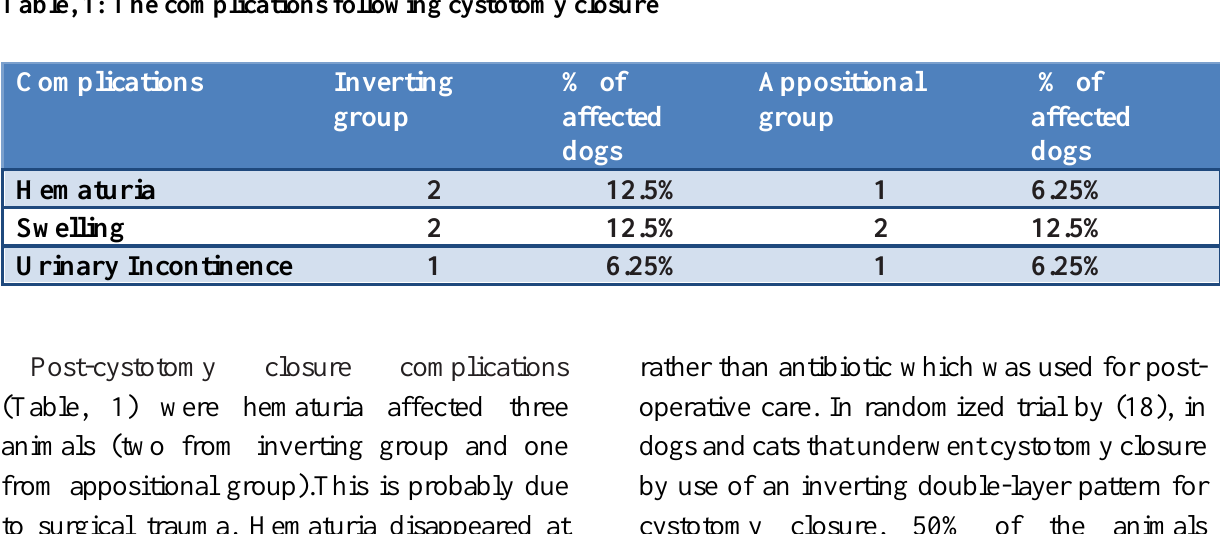
Table, 1: The complications following cystotomy closure